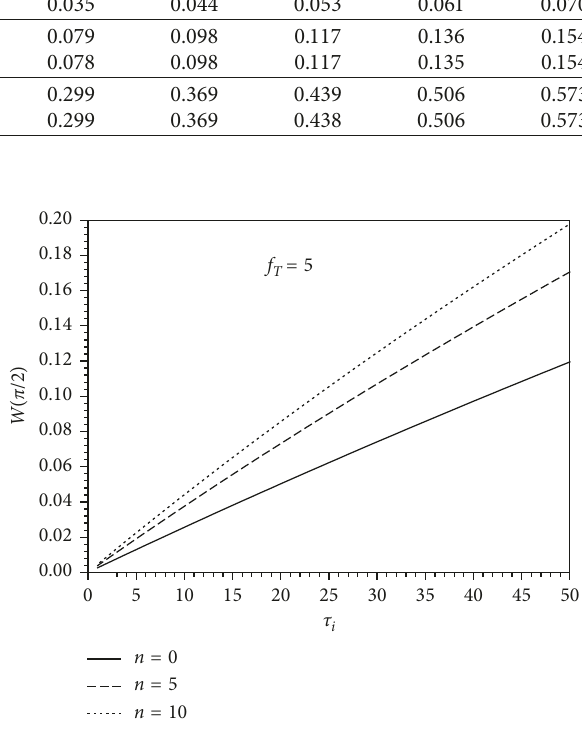
Figure 5: Variation of W ( λ 1/10). (cid:31)